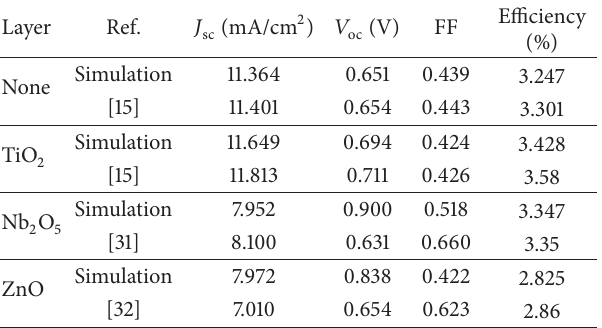
Table 2: Performance of DSC with various materials as passivation layer. Layer